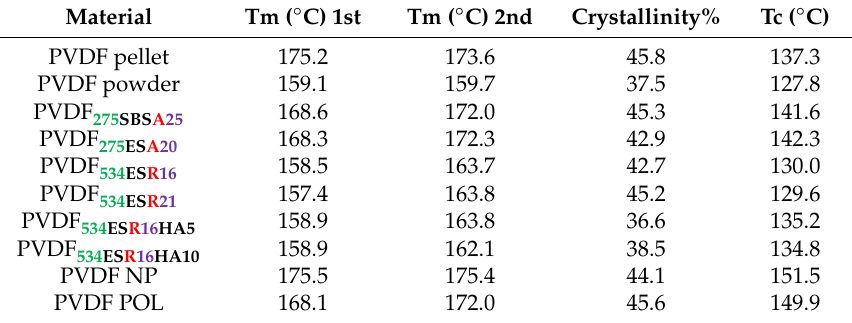
Table 2. Thermal properties of the fibrous membranes and respective raw materials assessed via DSC. T m and T c are melting temperature (for 1st and 2nd heating profiles) and the temperature of cold crystallisation, respectively.